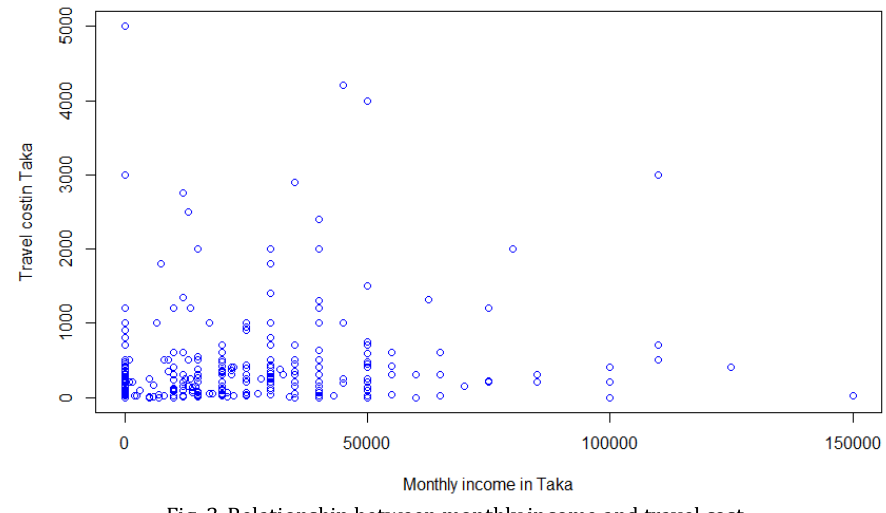
Fig. 3. Relationship between monthly income and travel cost